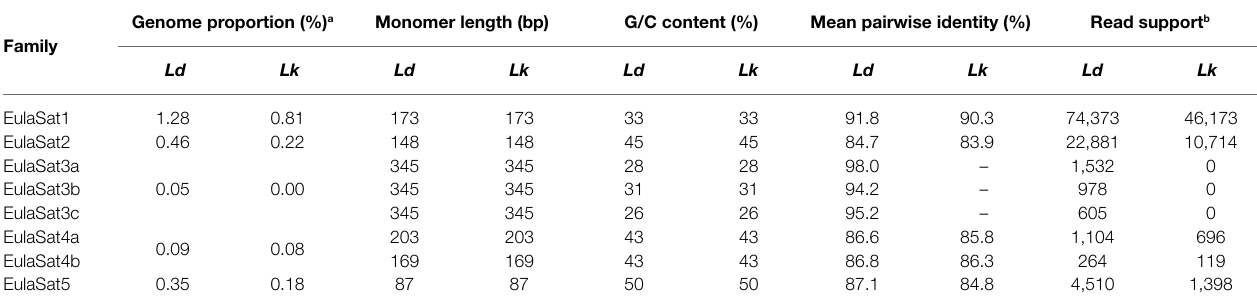
TABLE 3 | Characteristics of satDNA in L. decidua ( Ld ) and L. kaempferi ( Lk ) genomes.